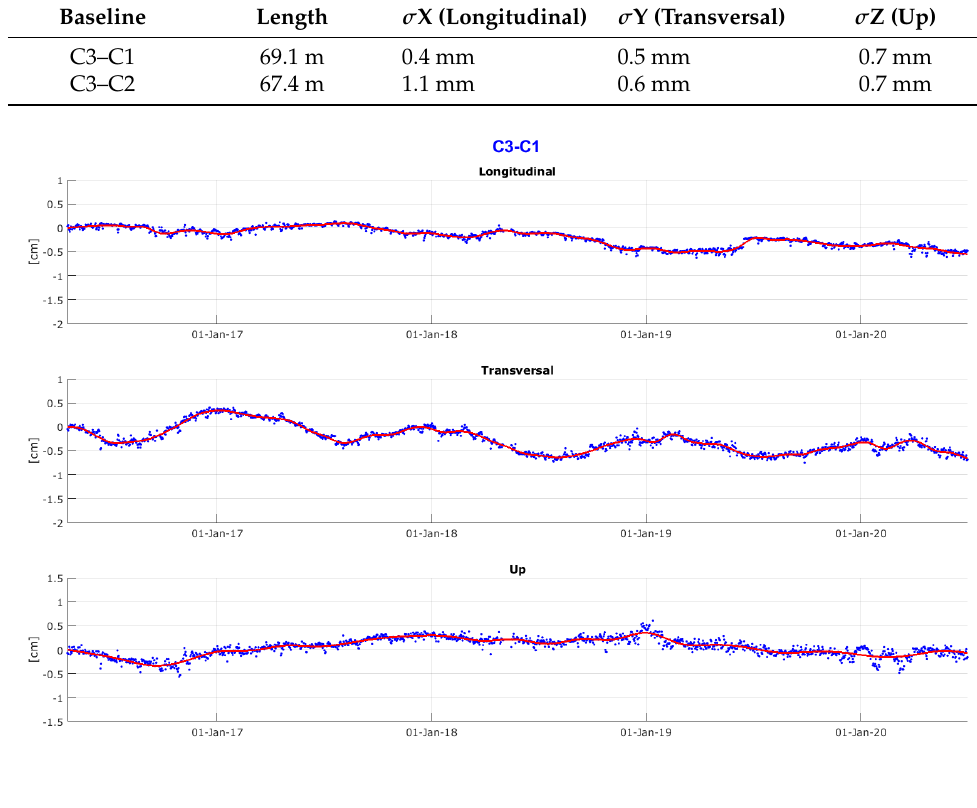
Table 2. Root mean squares (RMSs) of XYZ with respect to the mean motion (splines every 14 days) for the 2 baselines over the 6-year period.